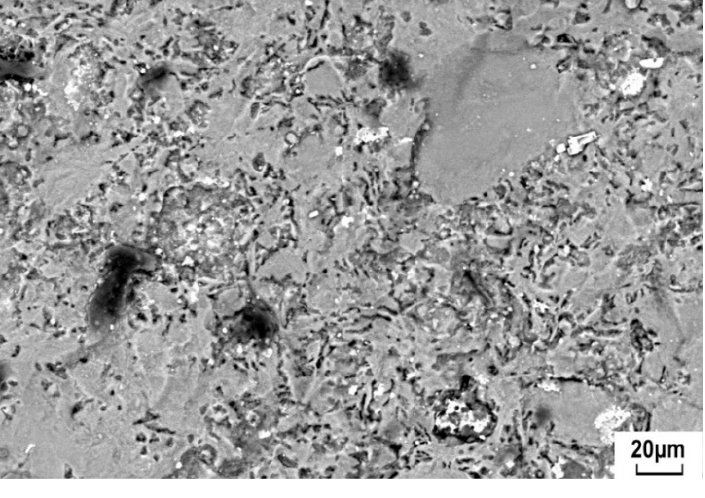
Figure 7. SEM image of ceramic paste texture with evidence of developed vitrification. The magnification 368×.